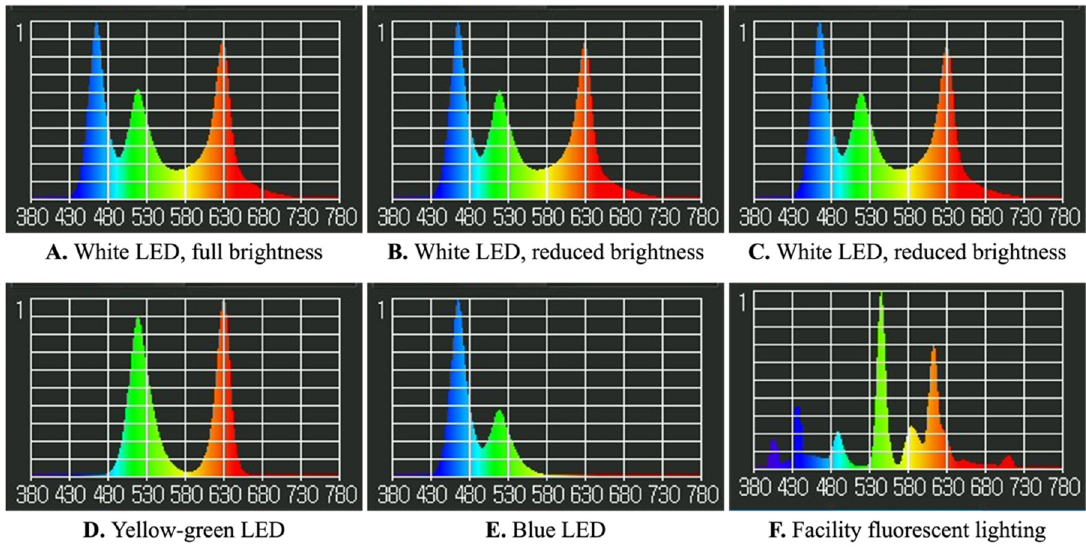
Figure A2. Spectral distributions produced by LED light treatments ( A – E ) and fluorescent facility lighting ( F ). Distributions shown are from one measurement from each light type.